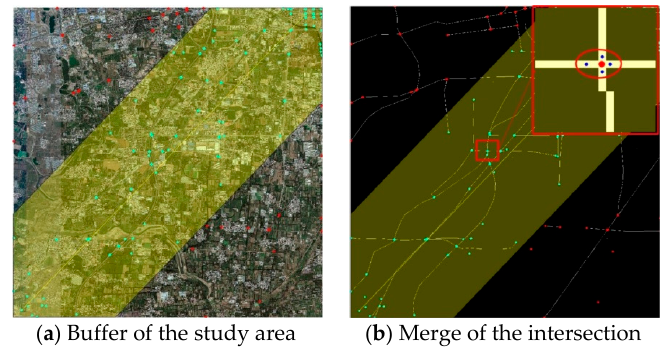
Figure 4. Reduction of nodes by buffering and merging.